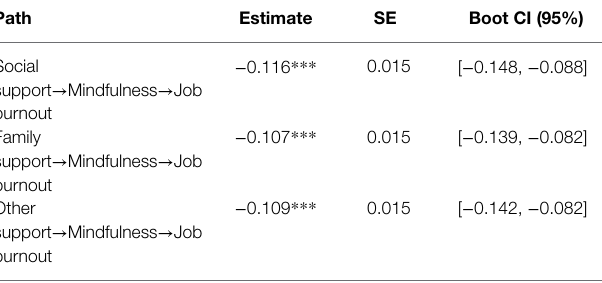
TABLE 3 | Bootstrap analysis of mediation effect